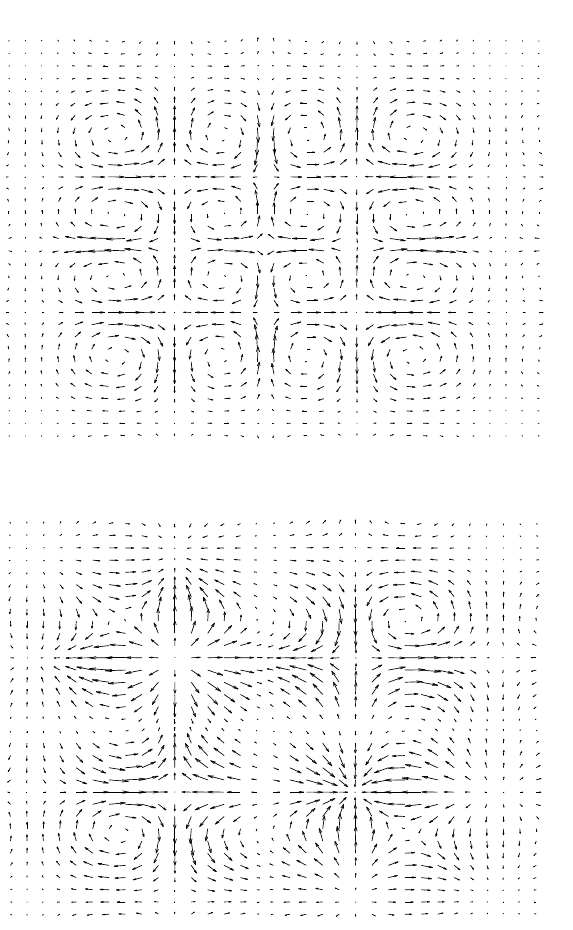
Figure 4. Some components of